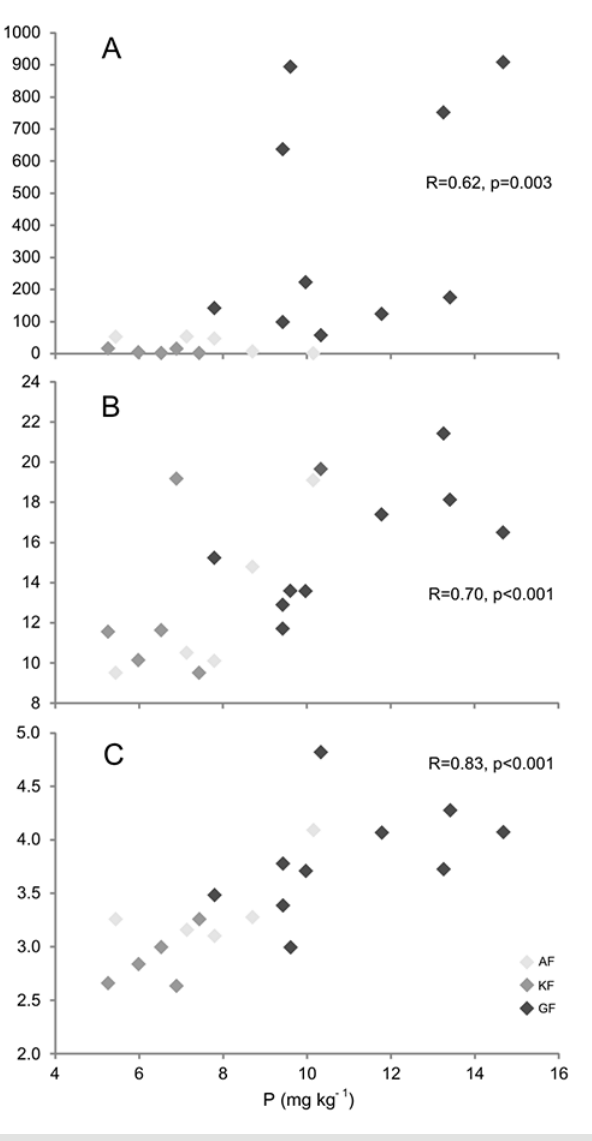
Fig. 4 Correlation between the concentration of available P (mg kg −1 ) and total number of flowering stems in the population ( A ), length (cm) of the longest leaf in rosette ( B ), and width (cm) of the longest leaf in rosette ( C ). AF – Augustów Forest; KF – Knyszyn Forest; GF – Grodno